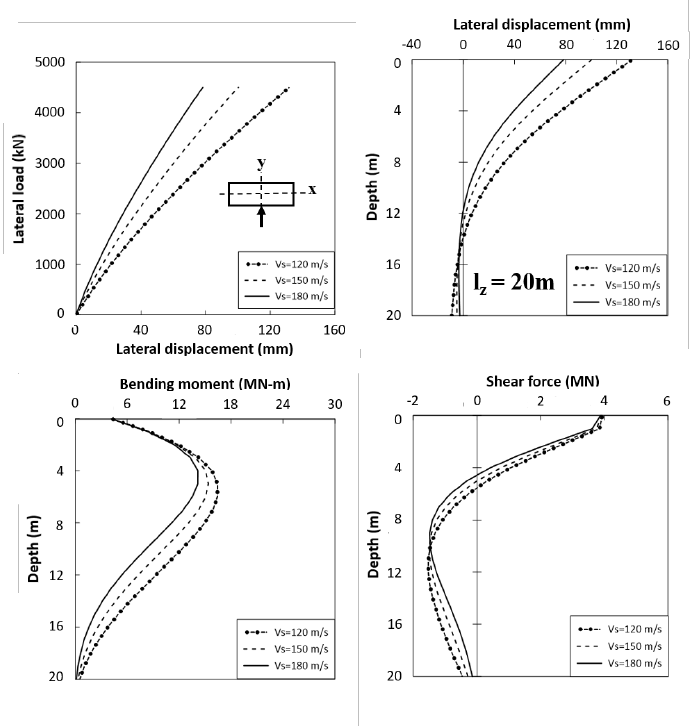
Fig. 8. Performance of 20m barrette in sands with load applied in transverse